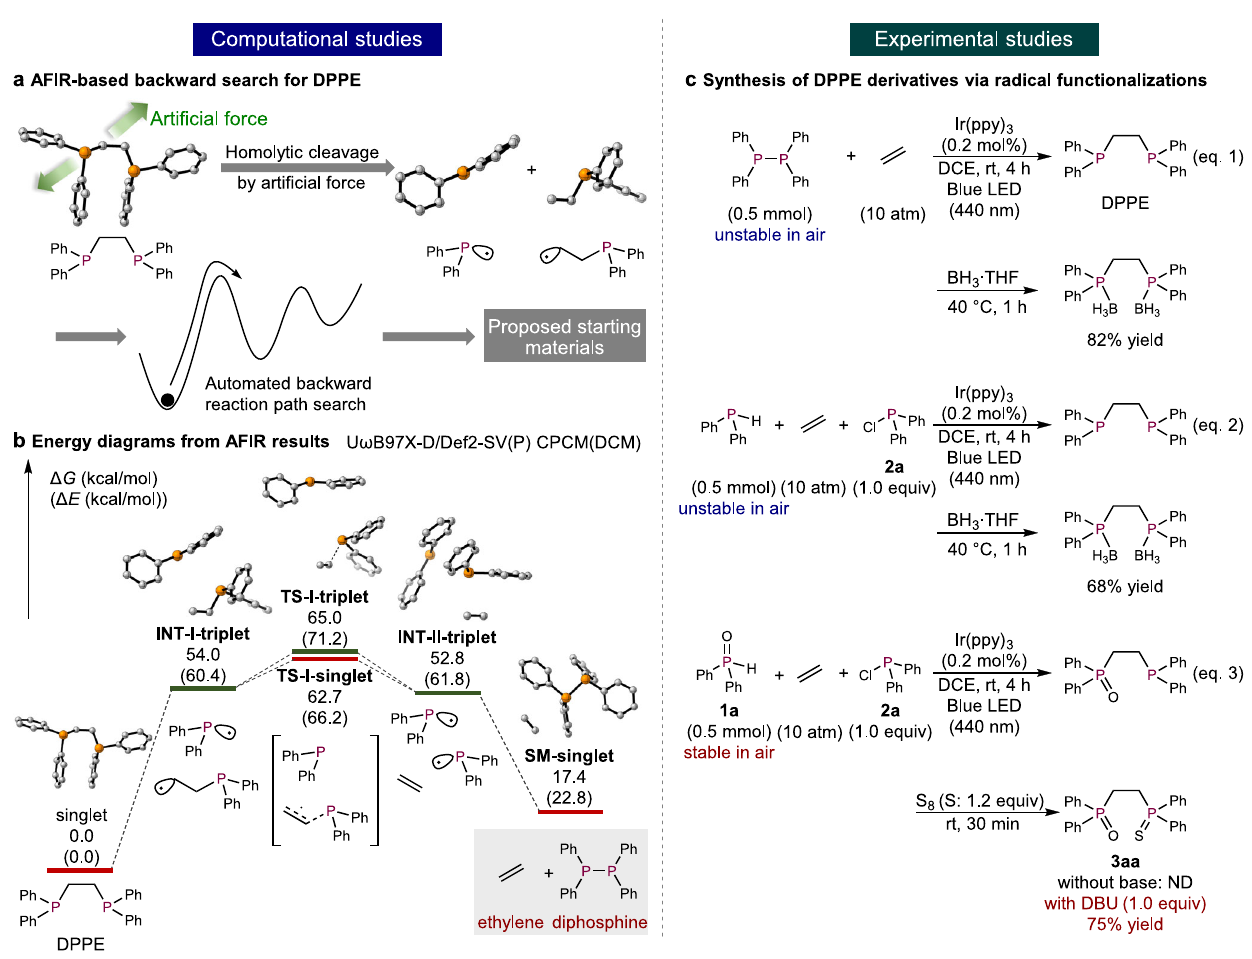
Fig. 2 | The AFIR-based reaction development for the synthesis of DPPEs. a Overview of the AFIR-based backward search for DPPE. b Retrosynthetic analysis of DPPE using AFIR. Thick red and green lines represent the calculation results for